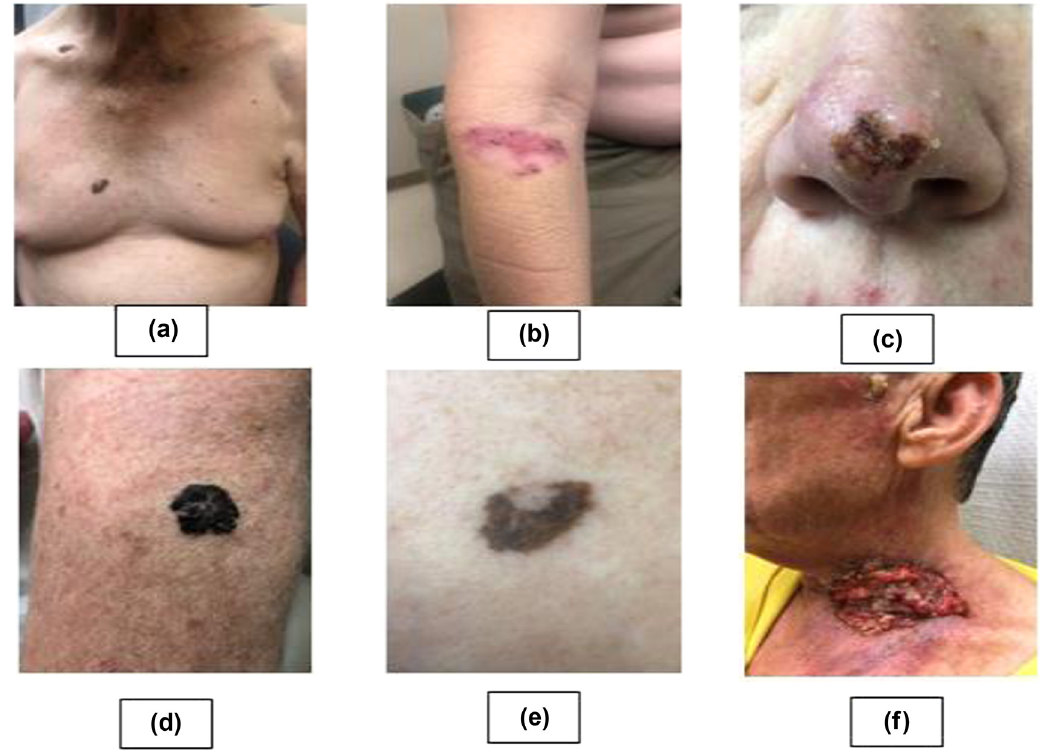
Figure 3: Clinical manifestations of di ff erent forms of skin cancer: ( a ) malignant melanoma distant view; ( b ) super fi cial BCC; ( c ) nodular BCC; ( d ) melanoma; ( e ) malignant melanoma with regression; ( f ) SCC ( photographs were provided by Robert T. Brodell, MD, Professor